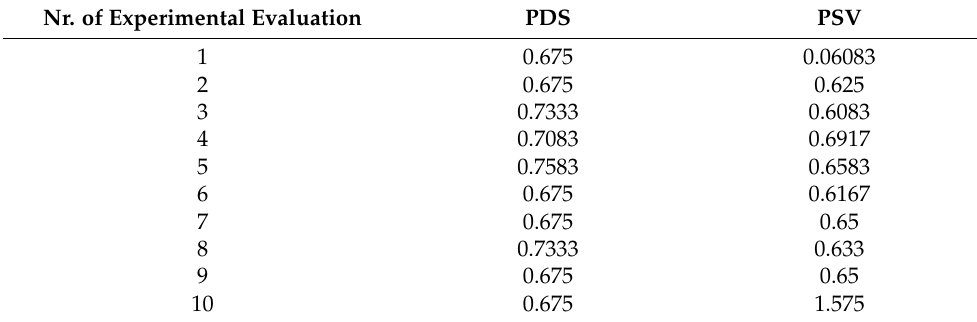
Table 3. Evaluation results for experiment 1.